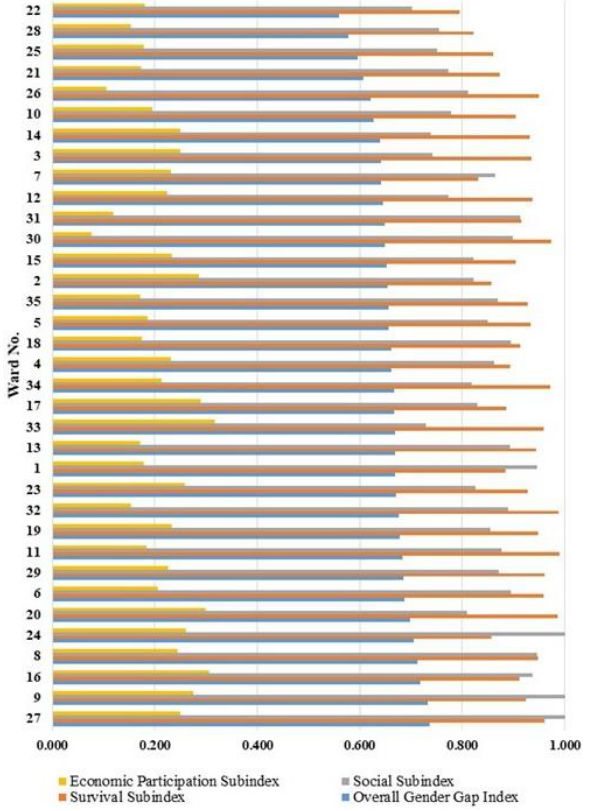
Fig. 2. Score on the subindices and overall Gender Gap Index, Sehore M.C.,